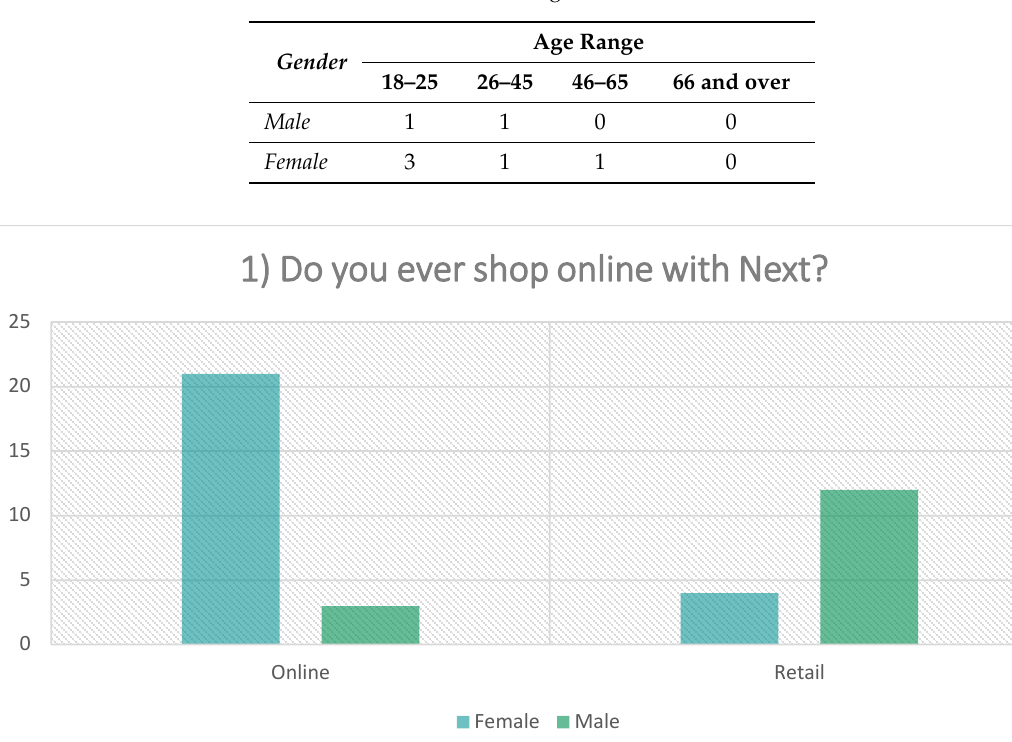
Figure 1. Demographics of respondents to Question 1 and their preferred shopping method.